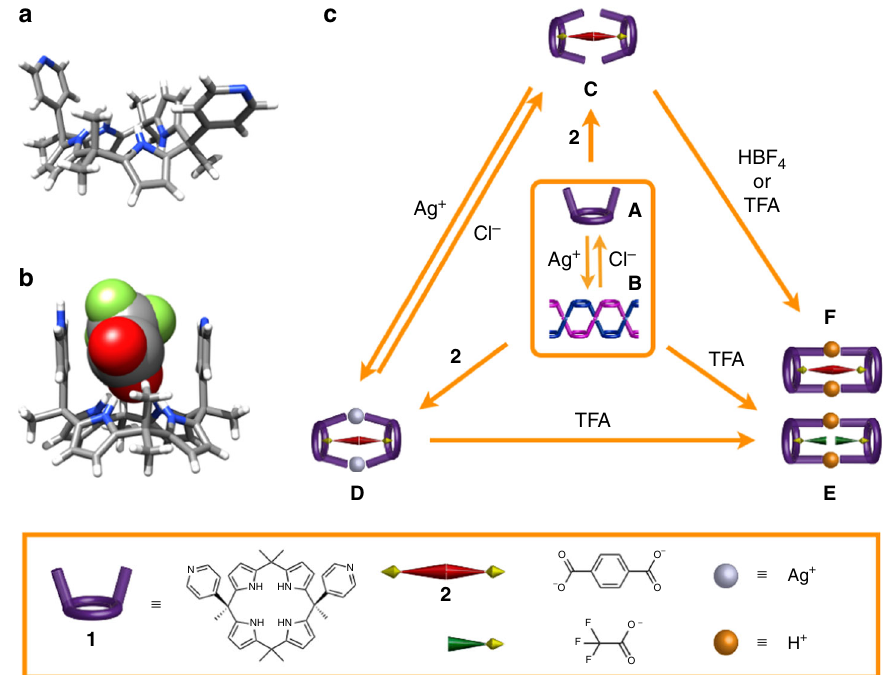
Fig. 1 Crystal structures and graphical summary of the underlying equilibria. a Single crystal X-ray structures of bispyridine-substituted calix[4]pyrrole 1 . b Single crystal structure of tri fl uoroacetate-bound 1 . c Schematic representation of single crystal X-ray structures of the six different equilibrium states that can be accessed by judicious addition of ionic